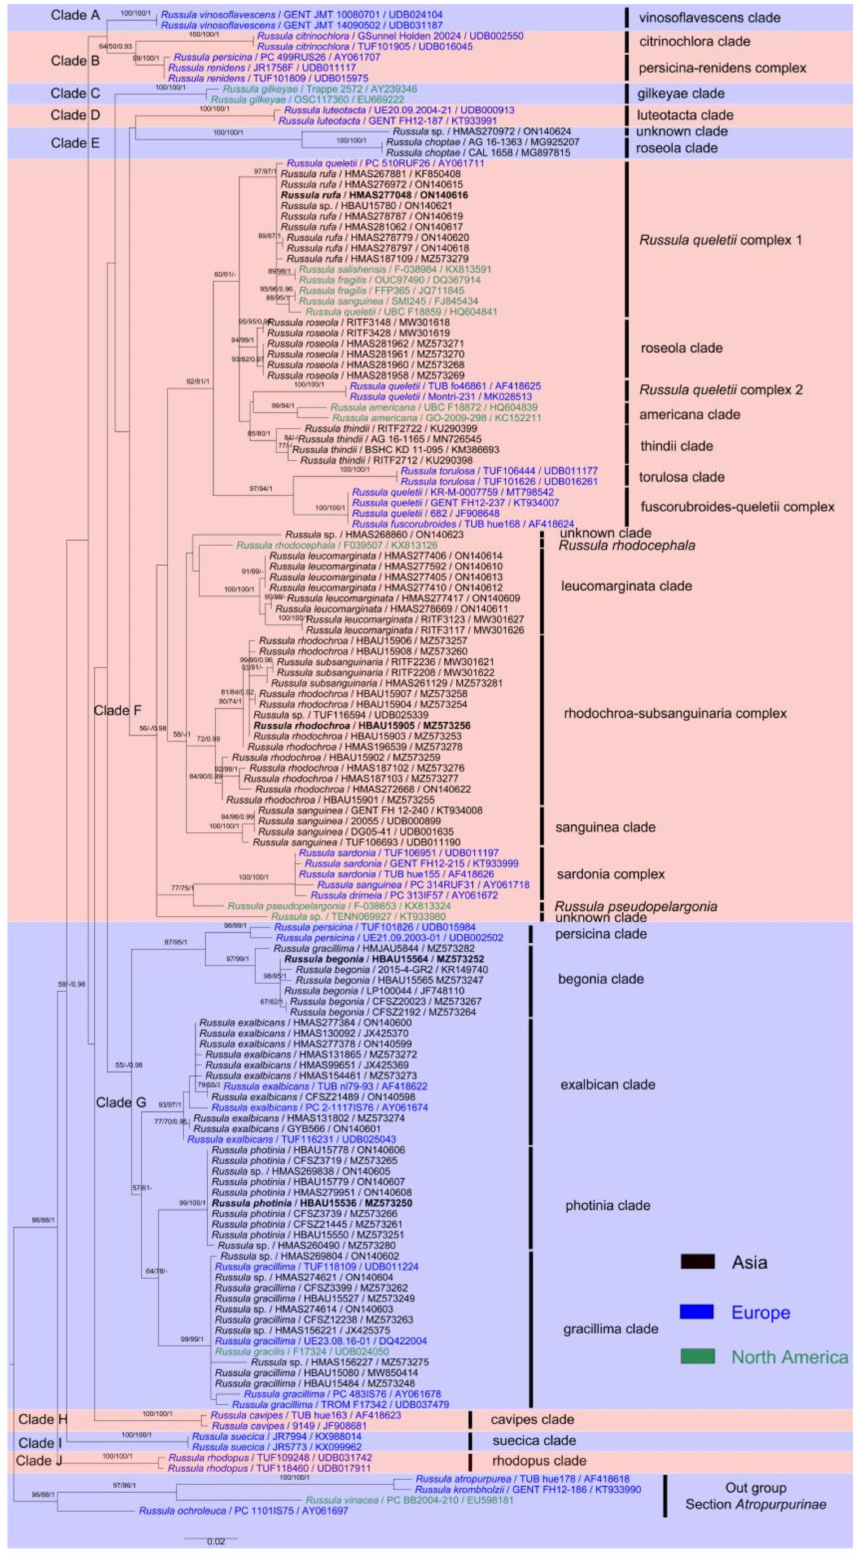
Figure 1. The ITS phylogenetic topology derived from maximum likelihood analysis. Bootstrap values ( ≥ 50%) of maximum likelihood (MLBS) and maximum parsimony (MPBS) analyses, together with posterior probability (PP) values ( ≥ 0.9) of Bayesian analysis, are presented above the branches as (MLBS/MPBS/PP). Holotypes of new species are shown in